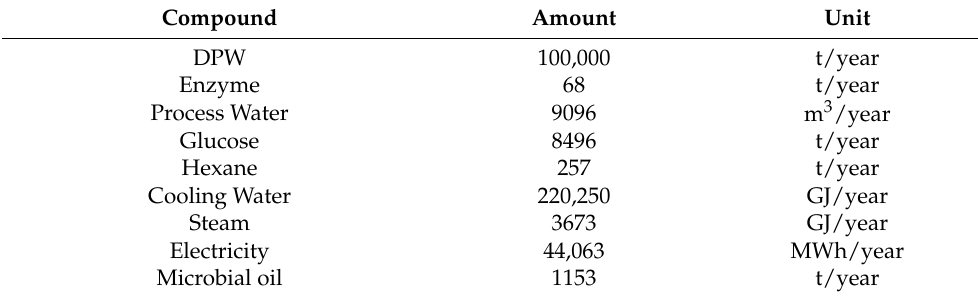
Table 8. Main material and energy inputs and outputs of the microbial oil process